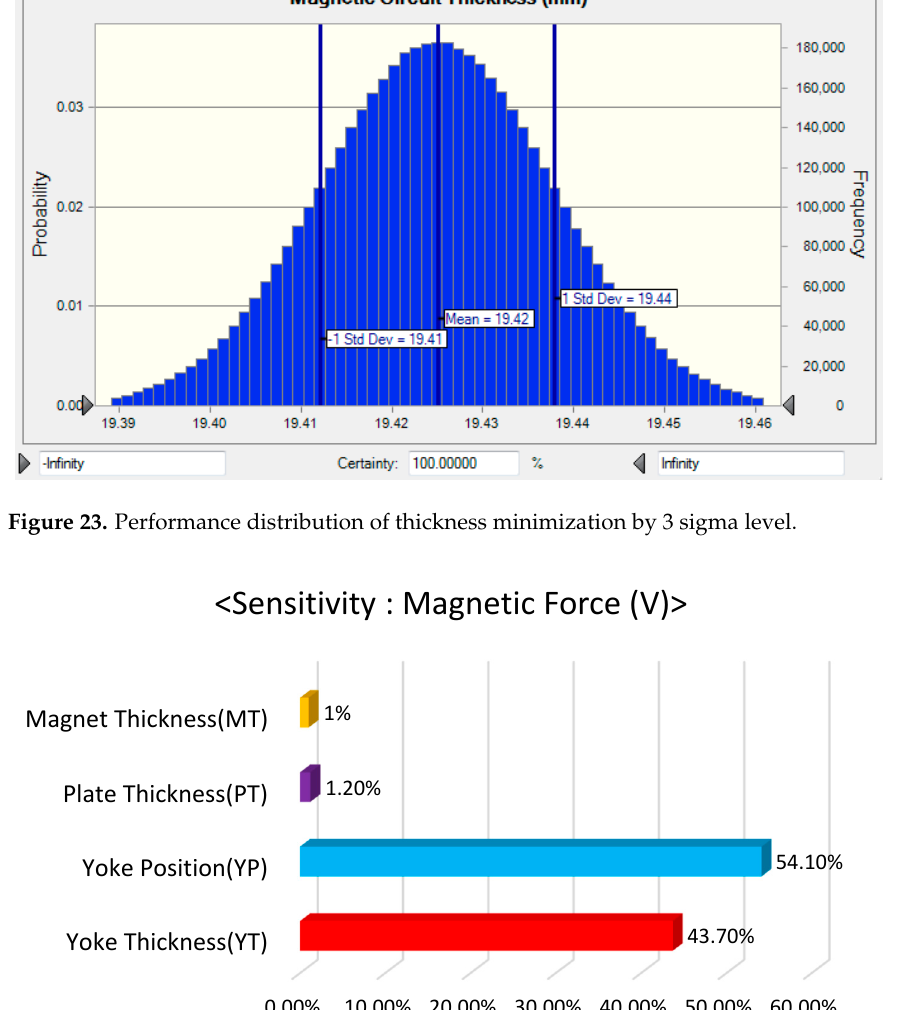
Figure 24. Analysis results of sensitivity by performance factor of 3 sigma level.